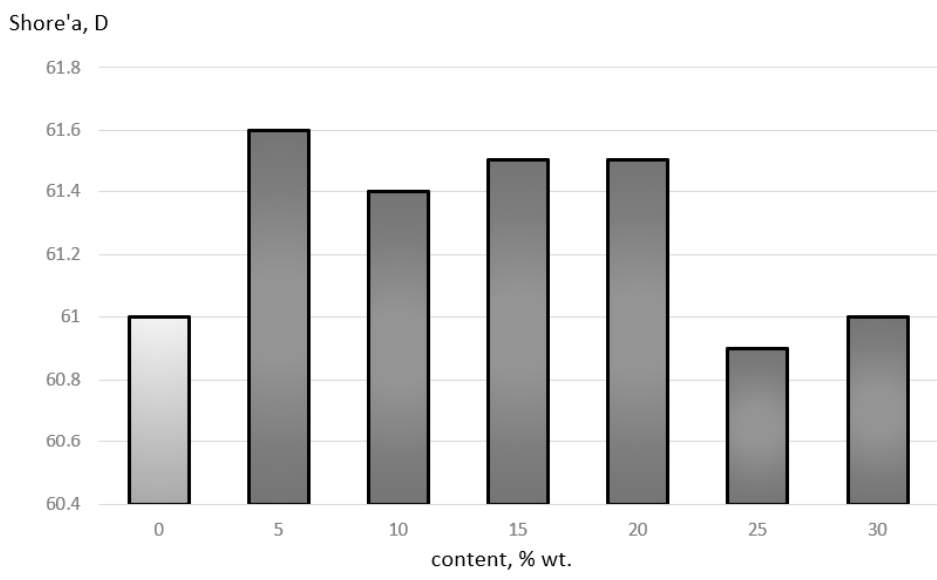
Figure 4. Change of hardness depending on the content of the Crusil M20 filler.